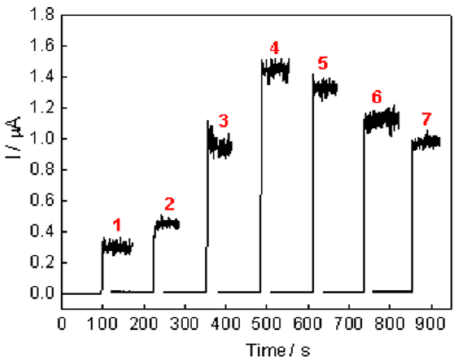
Figure 5. Amperometric responses of different layers of AuNRs-GOD bilayer films-modified Au electrode in 1 mM glucose (number of AuNRs-GOD indicated on